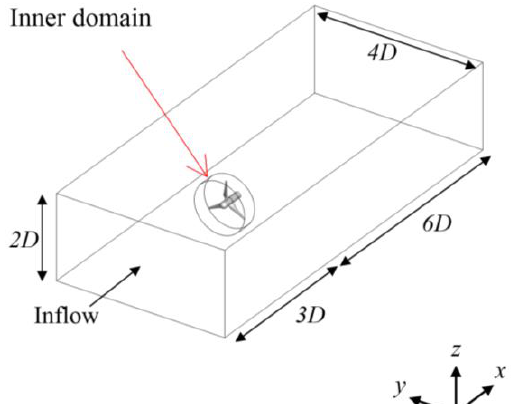
Fig. 1. Diagram of the computational domain showing the outer and inner domain regions, where the rotor and the coin-shaped domain surrounding it form the inner domain and the rest is the outer domain. The flow is in the positive x-direction and rotor rotation is in the clockwise direction (viewed from the flow